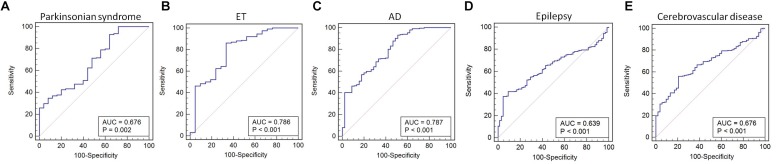
ROC curve for miR-105-5p between IPD and parkinsonian syndrome (A), ET (B), AD (C), epilepsy (D), and cerebrovascular disease (E). The areas under the ROC curve (AUC) were 0.676 (95% CI, 0.615–0.732; p = 0.002), 0.786 (95% CI, 0.731–0.835; p < 0.001), 0.787 (95% CI, 0.734–0.833; p < 0.001), 0.639 (95% CI, 0.587–0.689; p < 0.001, and 0.676 (95% CI, 0.624–0.725; p < 0.001), respectively. ET, essential tremor; AD, Alzheimer’s disease.